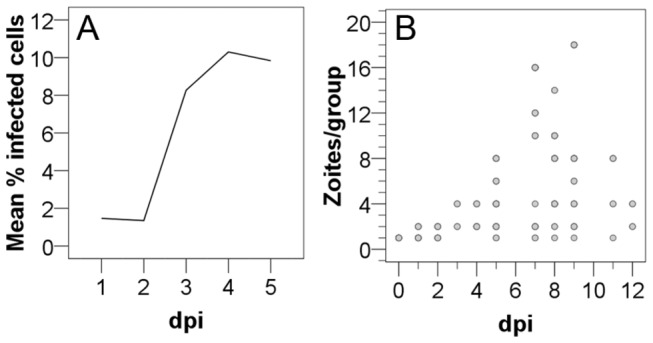
Dynamics of

I

. suis
 in intestinal porcine epithelial cells (IPEC-J2).Cells were infected with an infection dose of 1:10 (sporozoites: cells), medium with 5% FCS was used. The percentage of infected cells over time (A) and the number of zoites per group over time (B) are shown. A group was defined as the totality of merozoites derived from one dividing mother cell based on the arrangement of zoites in pairs or rosettes; dpi, days post infection.